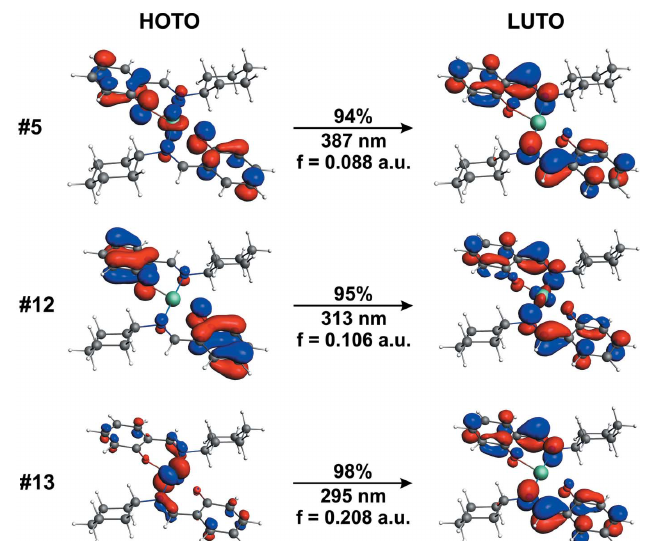
Figure 8 Isosurfaces ( (cid:8) 0.04 a.u.) of dominant NTO (natural transition orbital) pairs for the selected excited states of [Ni( L I ) 2 ] along with the percentage weights of hole–particle, corresponding S 0 ! S 1 transition wavelengths and oscillator strengths ( f ). HOTO = highest occupied transition orbital, LUTO = lowest occupied transition orbital.